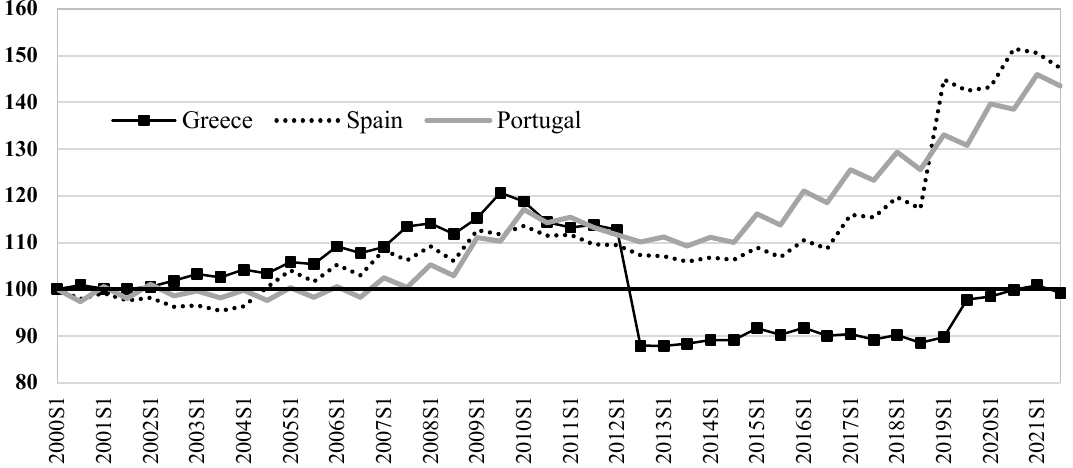
Figure 3. Biannual level of the Minimum Wage deflated, Greece, Portugal and Spain, 2000–2021 (2000S1 = 100). Source: Eurostat and authors’ calculations.